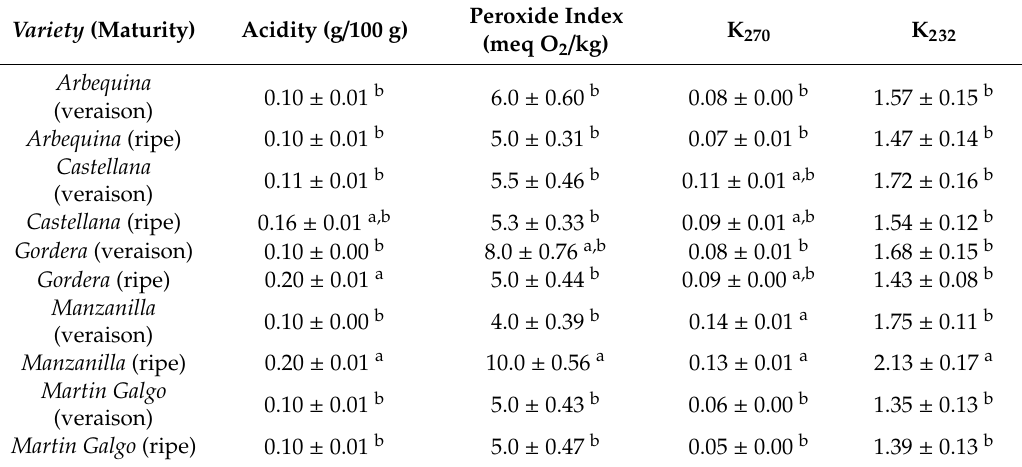
Table 1. Results obtained for the parameters of the regulated physical–chemical quality of the samples of virgin olive oil analyzed, from the di ff erent olive varieties grown in the study area, collected at di ff erent stages of